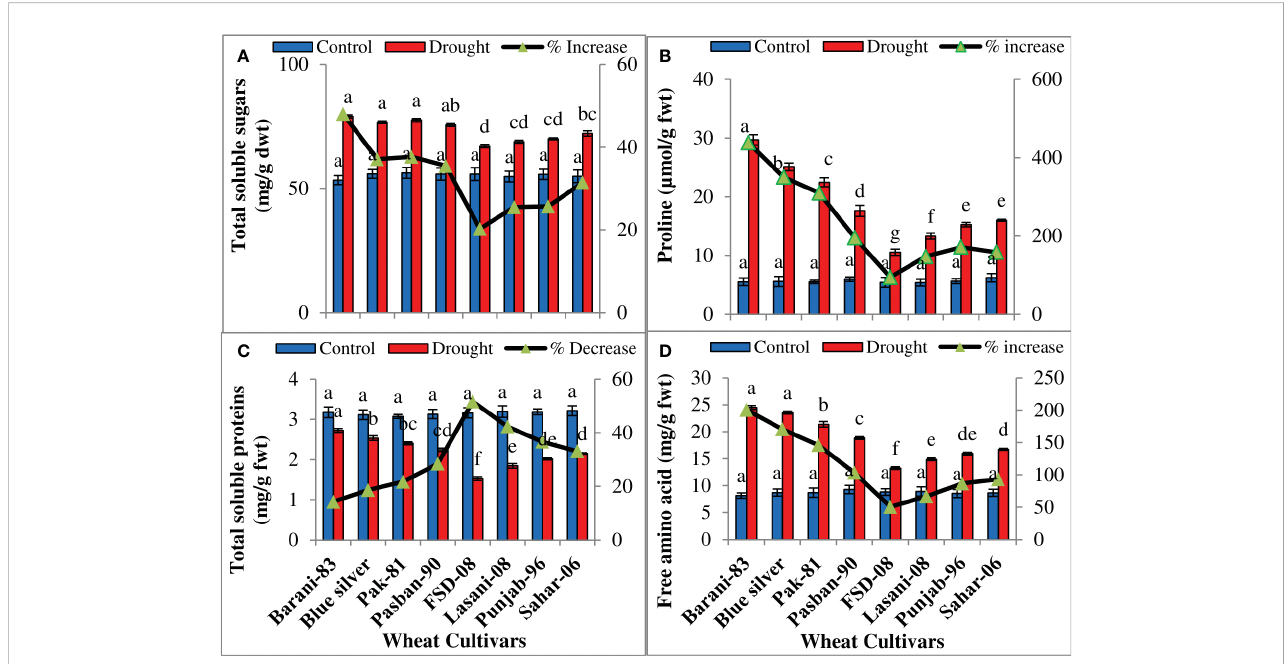
FIGURE 6 Accumulation of organic osmolytes in selected wheat cultivars subjected to control or drought stress at adult stage. Means (± SE; n=5) are presented on the primary vertical axis, while percent increase/decrease value is presented on the secondary vertical axis. Different letters represent signi fi cant differences among cultivars at p < 0.05 according to LSD test. (A) Total soluble sugars, (B) proline, (C) total soluble proteins, and (D) free amino